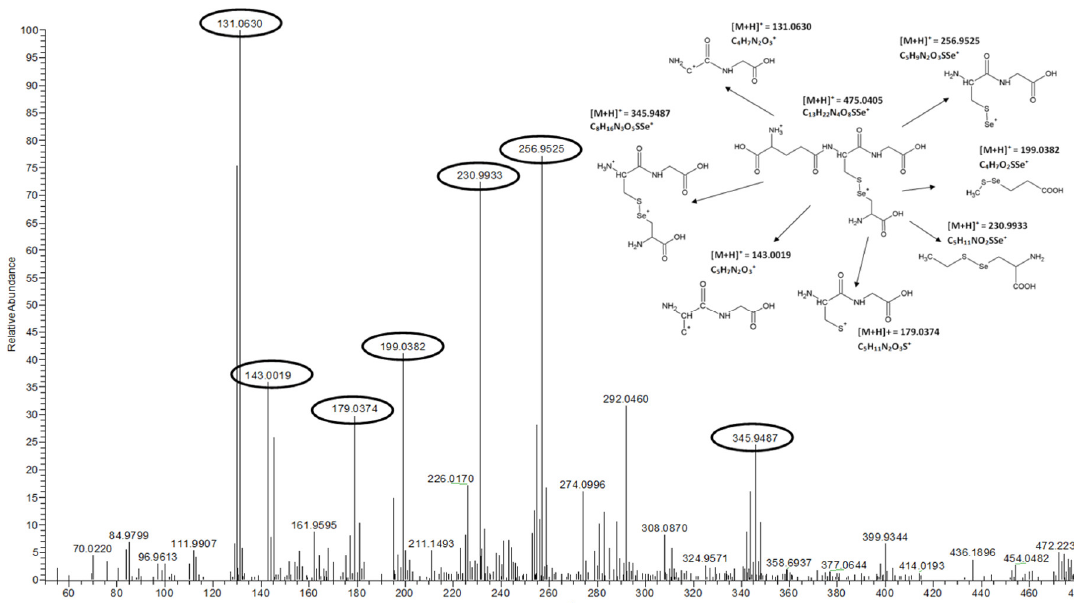
Figure 7. Fragmentation spectrum for ion with m/z = 475.0405 and fragmentation pathway.